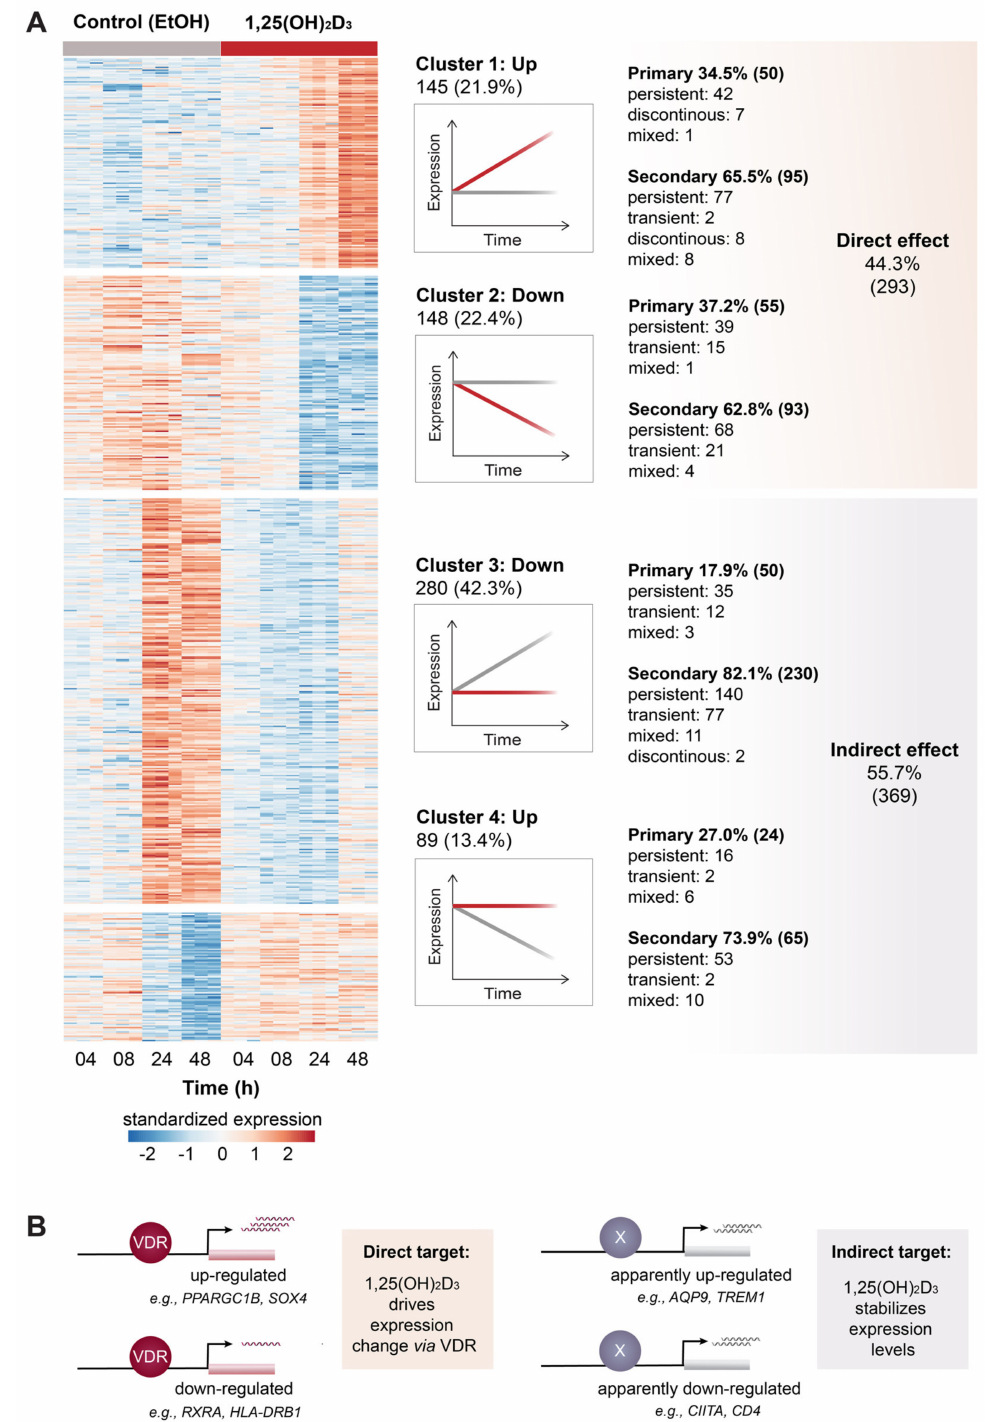
Figure 2. Clustering of vitamin D target genes. The machine learning algorithm k -means revealed four distinct clusters of vitamin D target genes based on cause and direction of expression change ( A ). 1,25(OH) 2 D 3 -driven expression changes indicated direct targets (clusters 1 and 2), whereas genes whose expression was primarily stabilized in the presence of 1,25(OH) 2 D 3 are indirect targets (clusters 3 and 4). This suggests an alternative view on vitamin D signaling: 1,25(OH) 2 D 3 either directly induces or reduces via VDR the expression of its target genes ( B , left ) or prevents their expression change mediated by other factors ( B , right